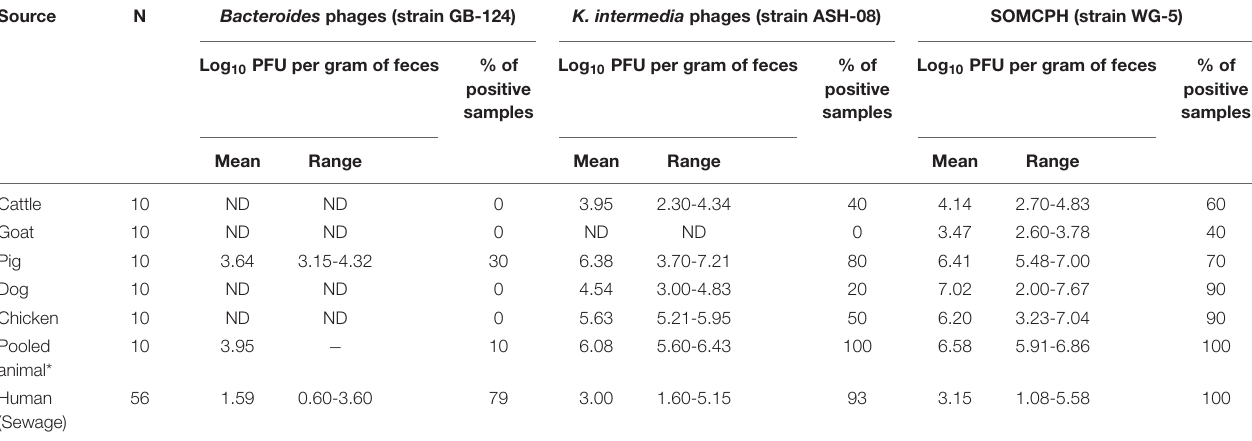
TABLE 1 | Analyses of samples from animal and human origin for phages against B. fragilis, K. intermedia, and somatic coliphages (SOMCPH) in Kolkata ( n = 116). Source